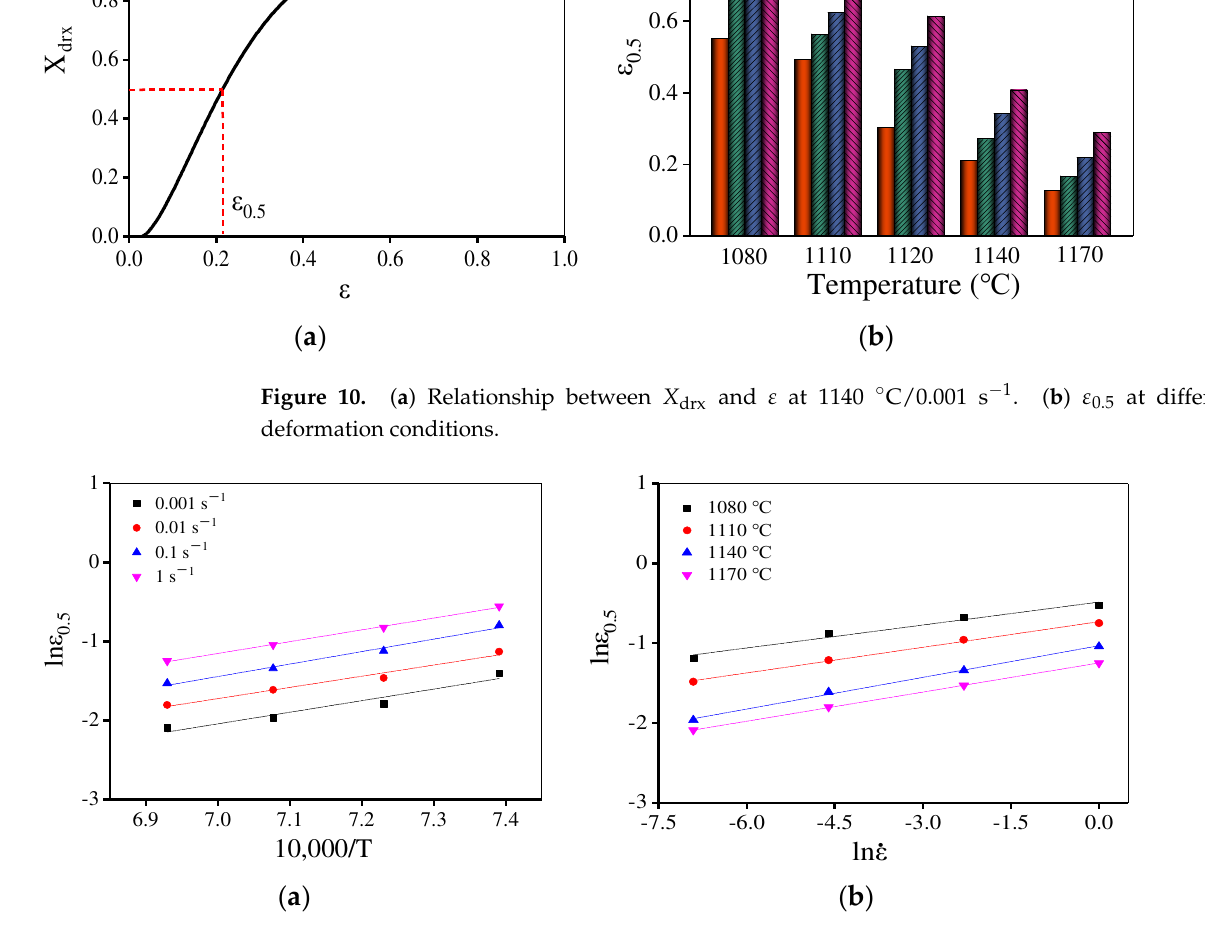
ln e –10,000/T and ( b ) ln e 0.5 0.5